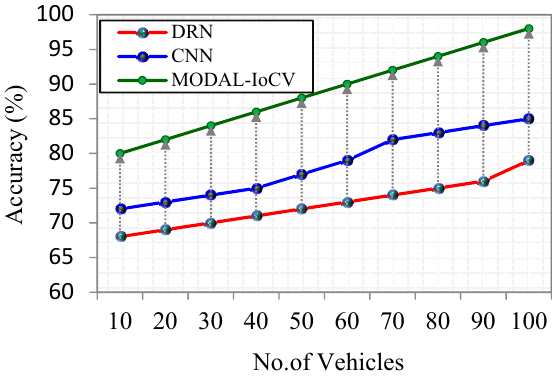
Figure 9. Number of vehicles vs. accuracy.